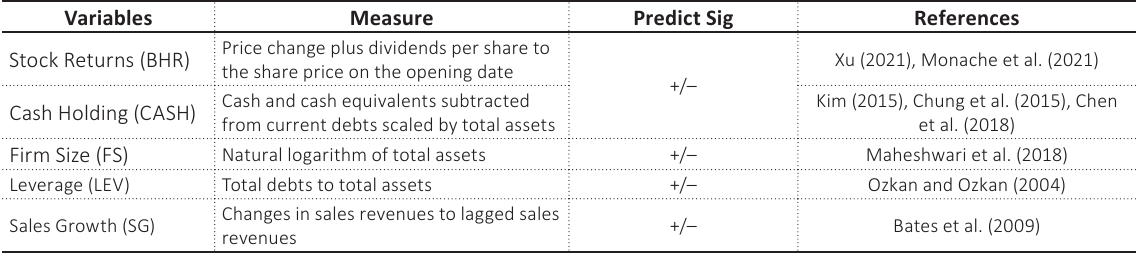
Table 1. Measurements of variables in this study